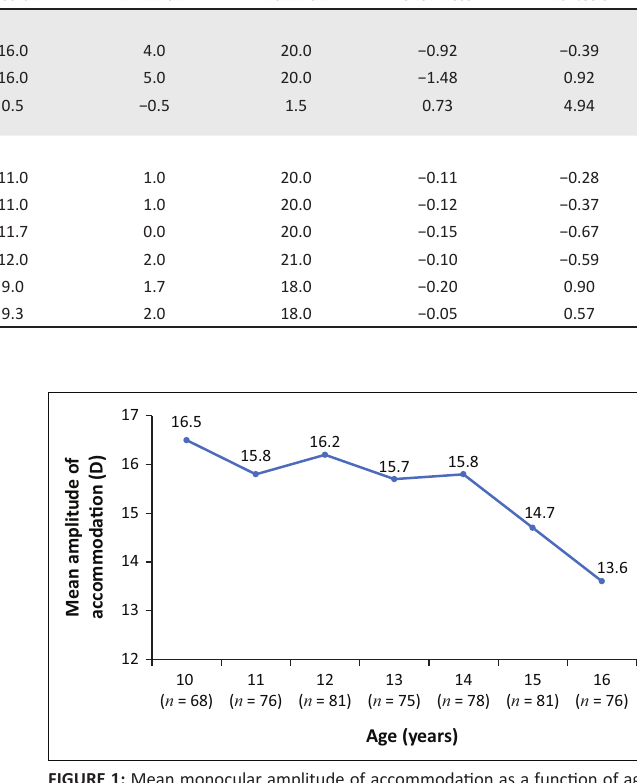
FIGURE 1: Mean monocular amplitude of accommodation as a function of age of schoolchildren ( N = 533) in Abia State.